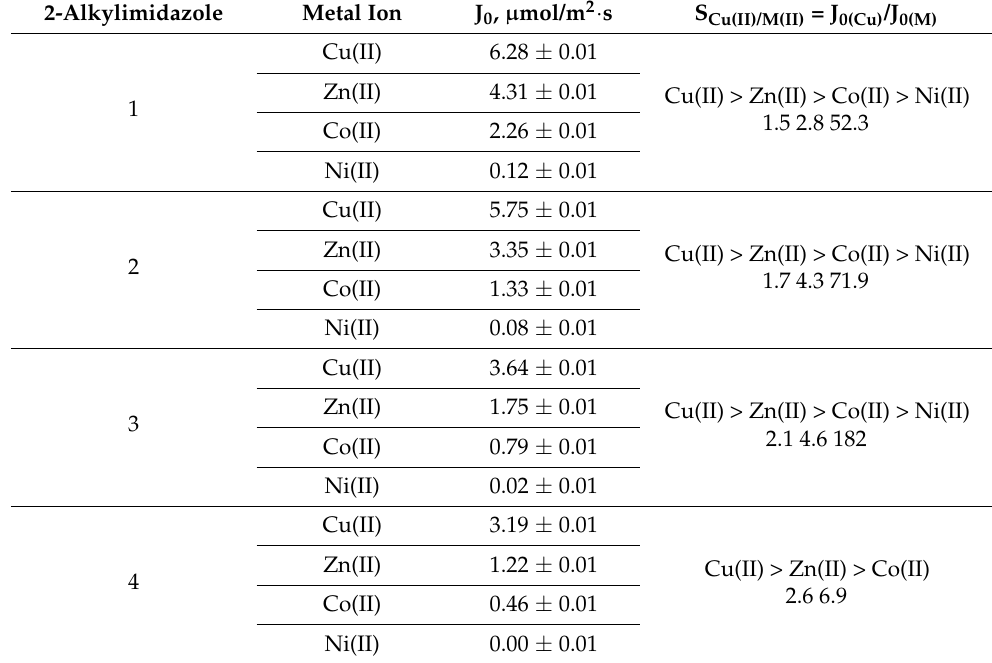
Table 3. Kinetic parameters of transport by PIMs containing 2-alkylimidazoles and selectivity coefficient of Cu(II)